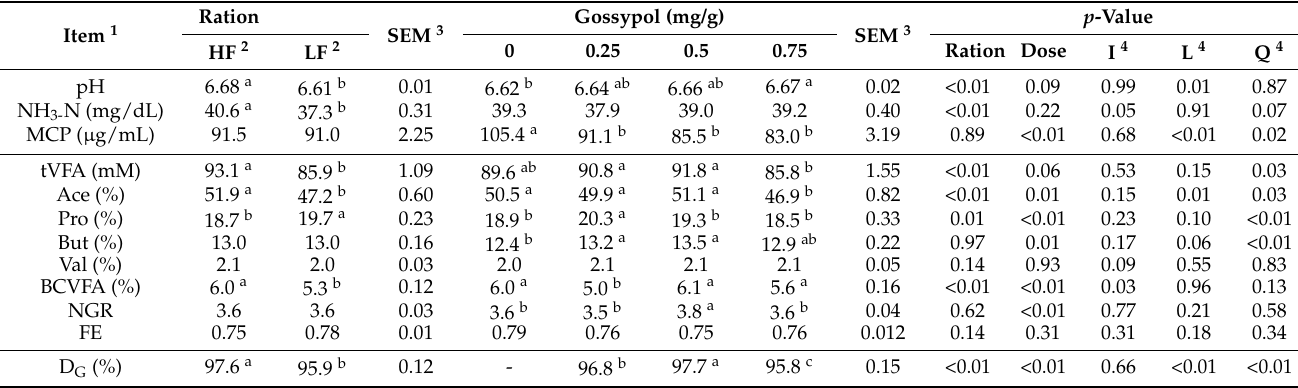
Table 4. Effect of different gossypol addition levels on in vitro fermentation characteristics of two rations after 48 h of